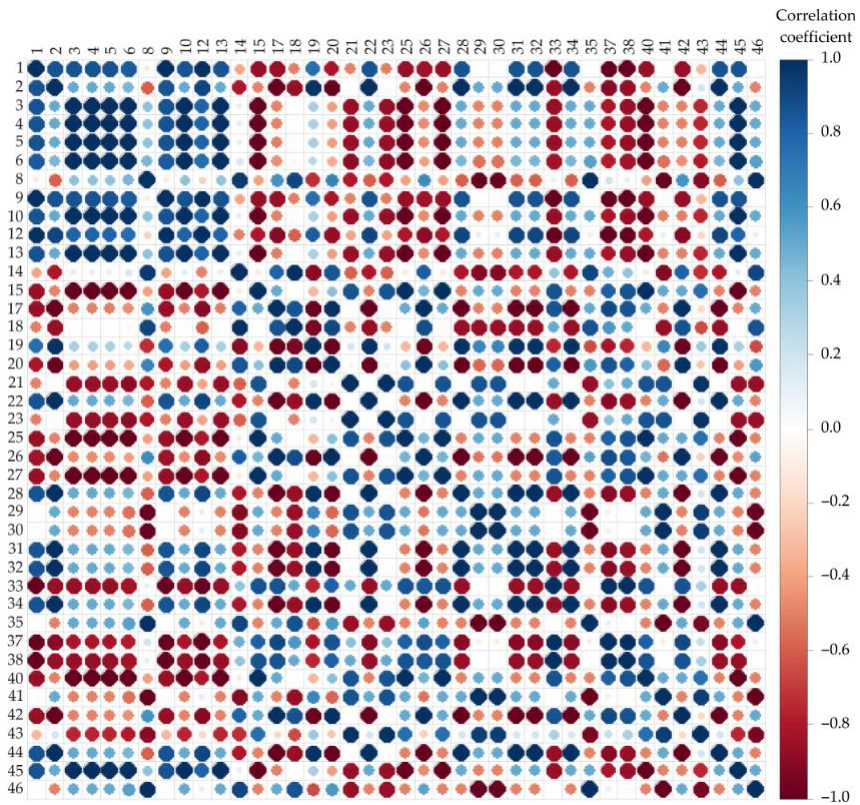
Figure 1. Correlation between volatile compounds of S. officinalis essential oil (the compounds were codded according to Table 3).